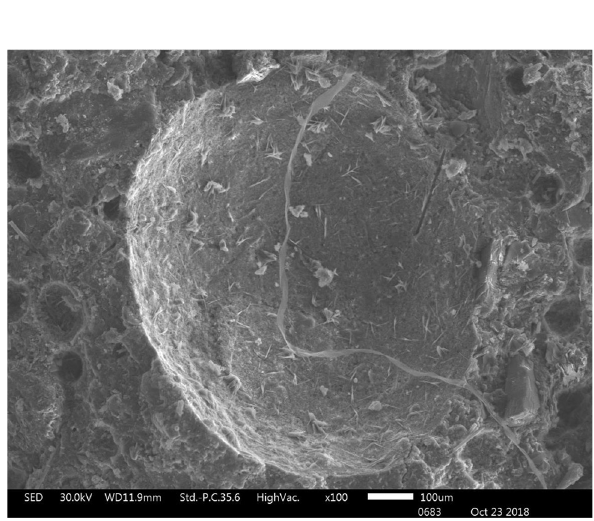
Figure 3: Scanning electron microscope picture of nano - CaCO 3